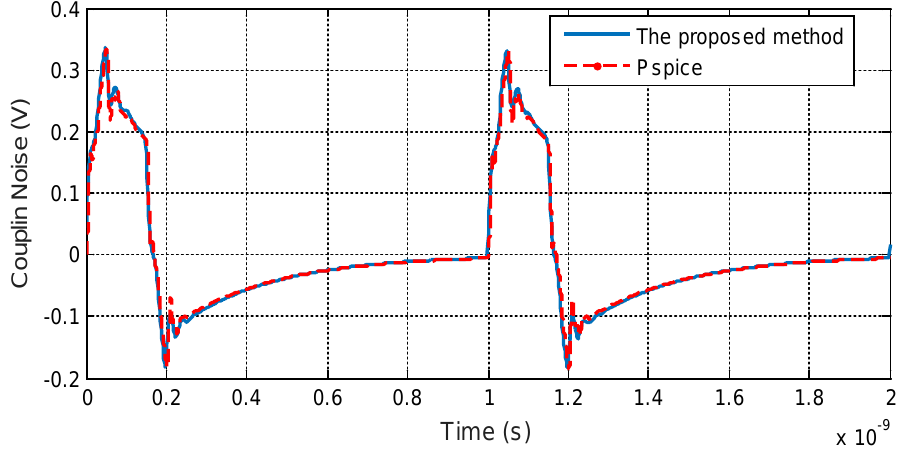
Figure 20. The proposed method and Pspice simulation of the TSV – TSV coupling noise with RDL ( l RDL = 500 µm and t r = 50 ps) at port 4.